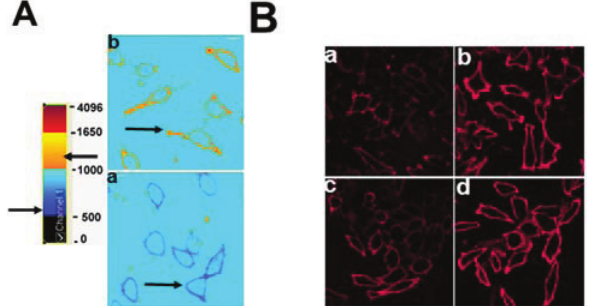
Figure 5. ABCG1 increases SM-enhanced cholesterol efflux. ( A ) Ratio fluorescence (red:green) of BODIPY-SM incorporation into control (a) and ABCG1 (b) PM. (B) Exogenous SM enriches control and ABCG1 PM SM. Control and ABCG1 cells treated without (a) and (c), respectively, or with exogenous SM, (b) and (d), respectively, were stained with SM-specific lysenin toxin. In ( C – F ) control and ABCG1 cells incubated in the absence ( solid black and green lines , respectively) or presence ( dashed black and green lines , respectively) of exogenous SM were labeled with 3 H-FC and then incubated with CD for 1 h at 4 °C ( C ), or for 10 min at 37 °C ( D ), or, with PC liposomes ( F ), or HDL ( G ). ( C ) SM-induced increase in PM non-SM-associated FC is enhanced by ABCG1. Difference curves represent (percent cholesterol efflux of (SM-treated cells)—(non-SM-treated cells)), dotted lines , control and ABCG1, black and green respectively.) ( D ) SM-induces increased cellular FC. Difference curves as in ( C ). ( E ) SM-induced increase in SM-associated-FC pool is enhanced by ABCG1. Control and ABCG1 cells treated with exogenous SM were incubated with ( dashed black and green lines, respectively), or, without ( solid black and green lines, respectively) SMase prior to CD-mediated FC efflux at 37 °C, as described above. Difference curves represent (percent cholesterol efflux of (SMase-treated cells)—(non-SMase-treated cells), dotted lines ; control and ABCG1, black and green, respectively.) ABCG1 increases SM-enhanced FC efflux to PC liposomes ( F ) and to HDL ( G ). For ( F ) and ( G ) control and ABCG1 difference curves were calculated as in ( C ) in are blue and red , for control and ABCG1 cells, respectively, in. All values are expressed as mean ± S.D. Data shown is representative of at least three replicate experiments. Two-way ANOVA analyses using multiple comparisons revealed in ( C ) that all values for cold CD-mediated efflux are significantly different ( p < 0.0001), except for control cells treated with exogenous SM (dashed black line) vs . untreated ABCG1cells (green solid line), p = 0.7632, p = 0.1093, and p = 0.8572, for 5, 10 and 20 mM CD, respectively. In ( D ), all values for warm CD-mediated efflux are significantly different ( p < 0.0001), except for control cells treated with exogenous SM (dashed black line) vs . untreated ABCG1cells (green solid line), p = 0.0419 and p = 0.3274, for 5 and 10 mM CD, respectively. In ( E ), all values for warm CD-mediated efflux are significantly different ( p < 0.0001), except for control cells treated with exogenous SM (solid black line) vs . ABCG1 cells treated with exogenous SM (green solid line), p = 0.6892 and p = 0.1857, for 5 and 10 mM CD, respectively. In ( F ), all values are significantly different ( p < 0.0001). In ( G ), all values are different except for control cells treated with exogenous SM (dashed black line) vs . untreated ABCG1cells (green solid line), p = 0.1991, p = 0.1715, and p = 0.1319, for 25, 50 and 100 μg/mL HDL,